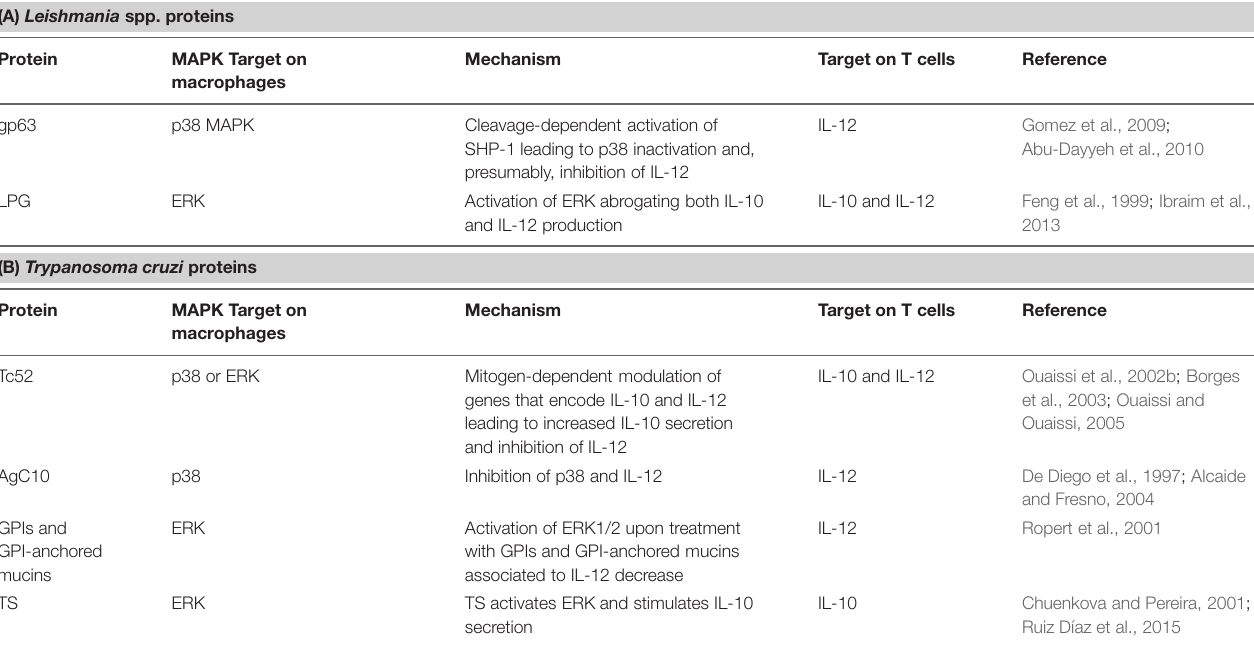
TABLE 1 | Trypanosomatids-released proteins and their action on MAPK pathway in macrophages and T